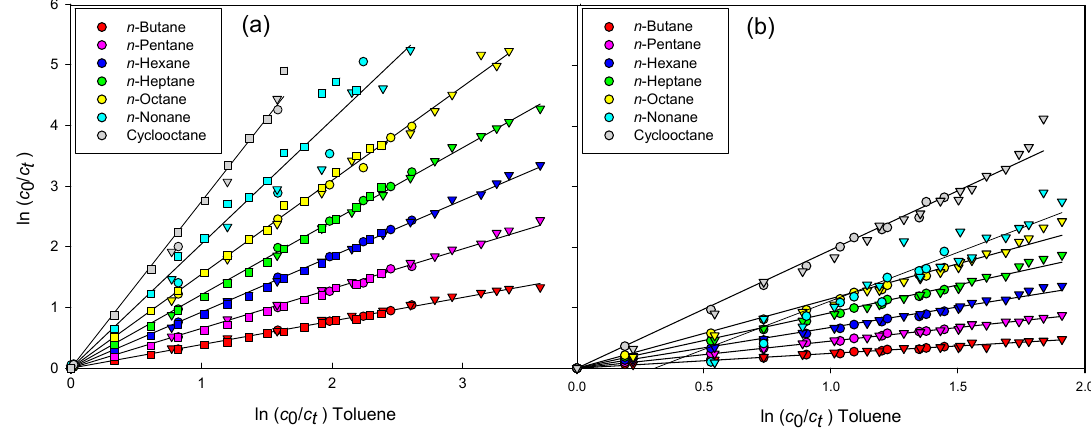
Figure 3. Plot of ln( c 0 / c t ) of straight-chain alkanes and cyclooctane versus toluene (reference substance). ( a ) Data points of three experimental runs at 288 K; ( b ) Data points of two experimental runs at 248 K. The curvature of the data and the non-zero intercept for n -nonane at 248 K indicate experimental limitations of adsorption in the sampling capillary of the gas chromatograph. The symbols ▽ , ○ and □ distinguish data points from di ff erent experimental runs, plots of branched- chain alkanes and aromatic hydrocarbons are displayed in the SI. Table 1. Rate constants for the reaction of OH radicals with hydrocarbons at 288 K.